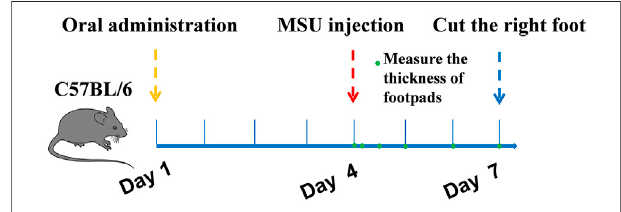
FIGURE 1 | Schematic experimental protocols.